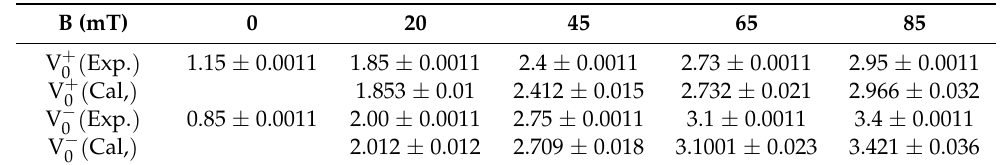
Table 1. The experimental and the calculated values of V 0 at different B for positive and negative corona discharge.